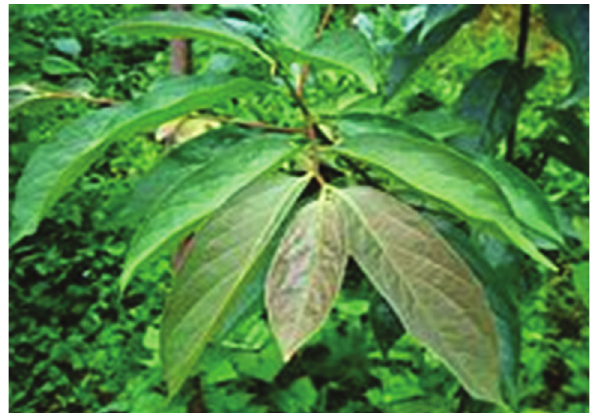
Figure 1: Pictorial representation of leaves of Diospyros lotus